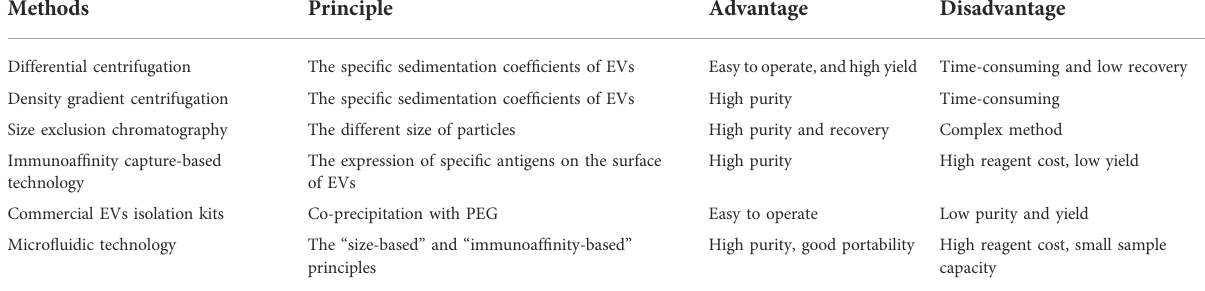
TABLE 3 Commonly isolation methods of